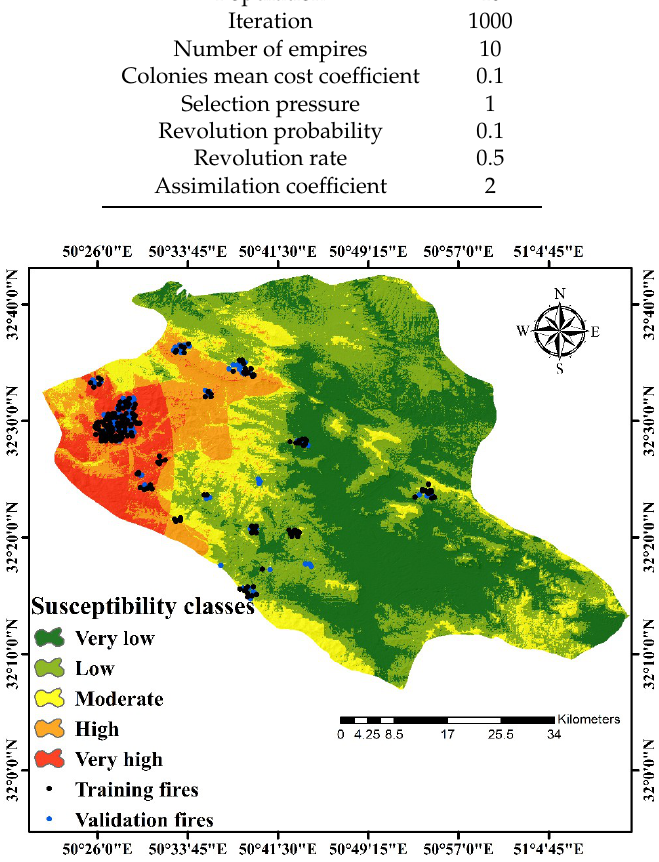
Figure 14. FFSM using the RBF-ICA model.